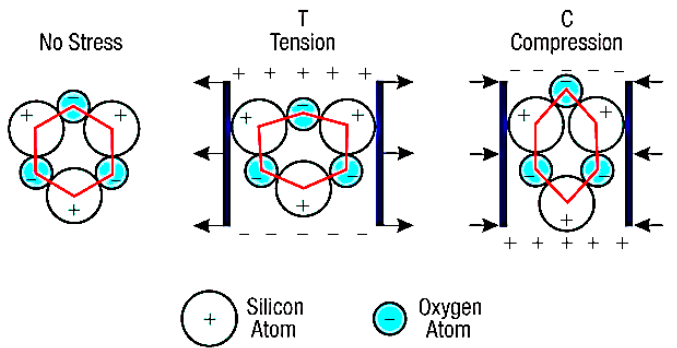
Figure 2. Piezoelectric effect in quartz.